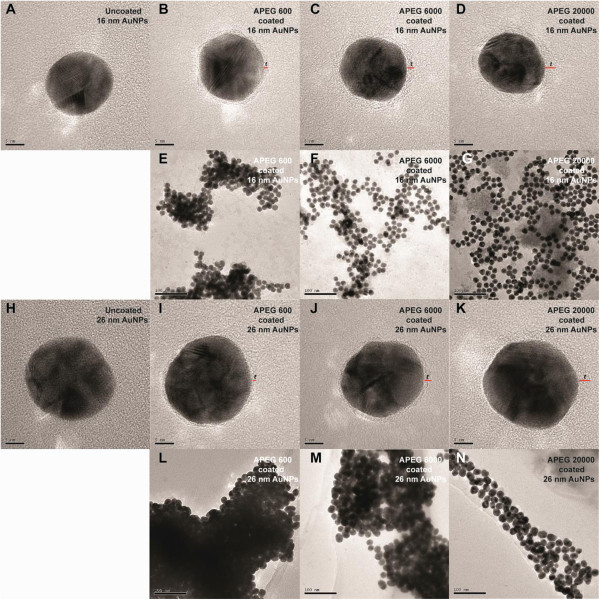
TEM images of uncoated and PEG-coated AuNPs. TEM images of uncoated AuNPs: (A) 16-nm AuNPs and (H) 26-nm AuNPs. TEM images of fully coated AuNPs in the absence of 10.0% (w/v) NaCl solution for 16-nm AuNPs: (B) APEG 600, (C) APEG 6,000, and (D) APEG 20,000; for 26-nm AuNPs: (I) APEG 600, (J) APEG 6,000, and (K) APEG 20,000. TEM images of fully coated AuNPs in the presence of 10.0% (w/v) NaCl solution for 16-nm AuNPs: (E) APEG 600, (F) APEG 6,000, and (G) APEG 20,000; and for 26-nm AuNPs: (L) APEG 600, (M) APEG 6,000, and (N) APEG 20,000. The t represents the thickness of the dehydrated PEG adlayer (red line). The scale bars are 5 nm (A to D), (H to K) and 100 nm (E to G), (L to N), respectively.